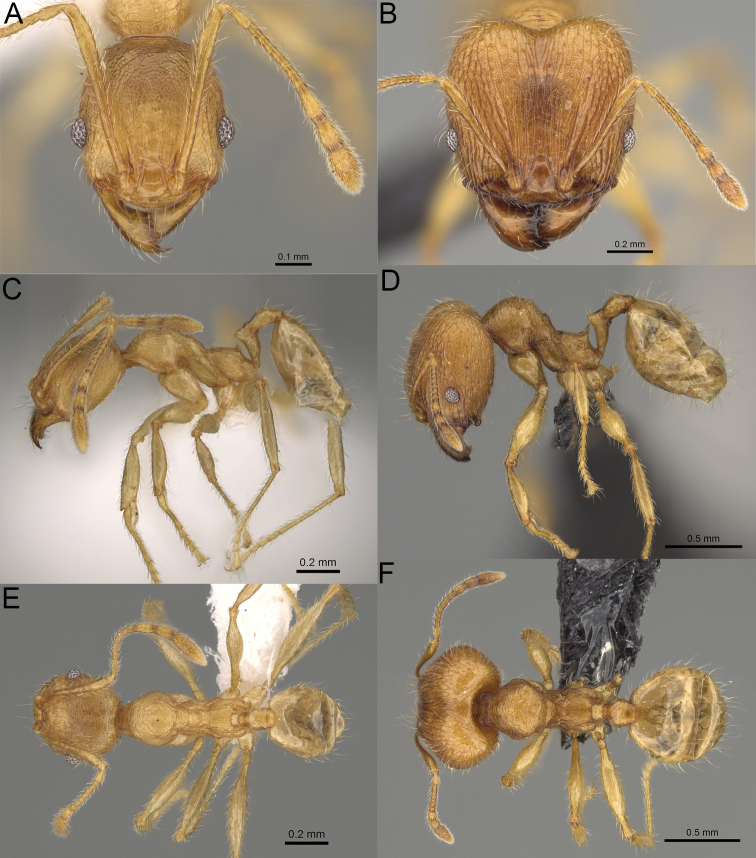
Pheidole
hazo sp. nov., full-face view (A), profile (C), and dorsal view (E) of paratype minor worker (CASENT0427762) and full-face view (B), profile (D), and dorsal view (F) of holotype major worker (CASENT0427790).